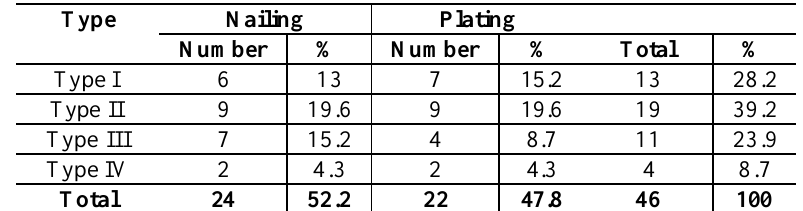
Table II : Comminution classification (Winquist - Hansen) n=46